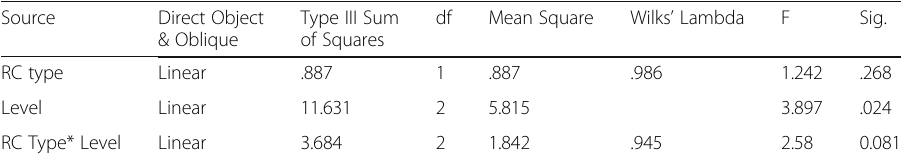
Table 2 The Effect of RC Type and Level on the Participants ’ Scores Source